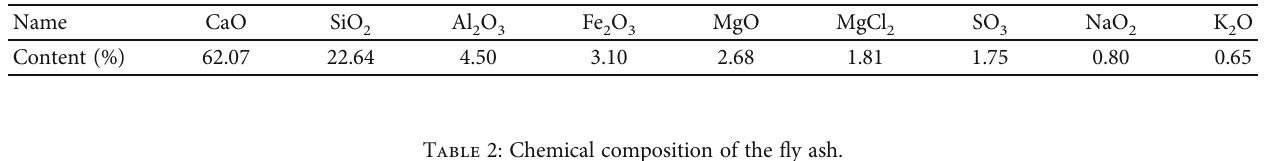
Table 1: Chemical composition of the cement.